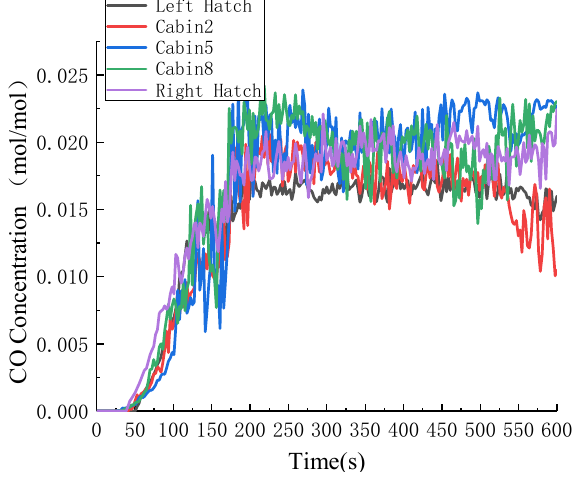
Figure 7. CO concentration curve.